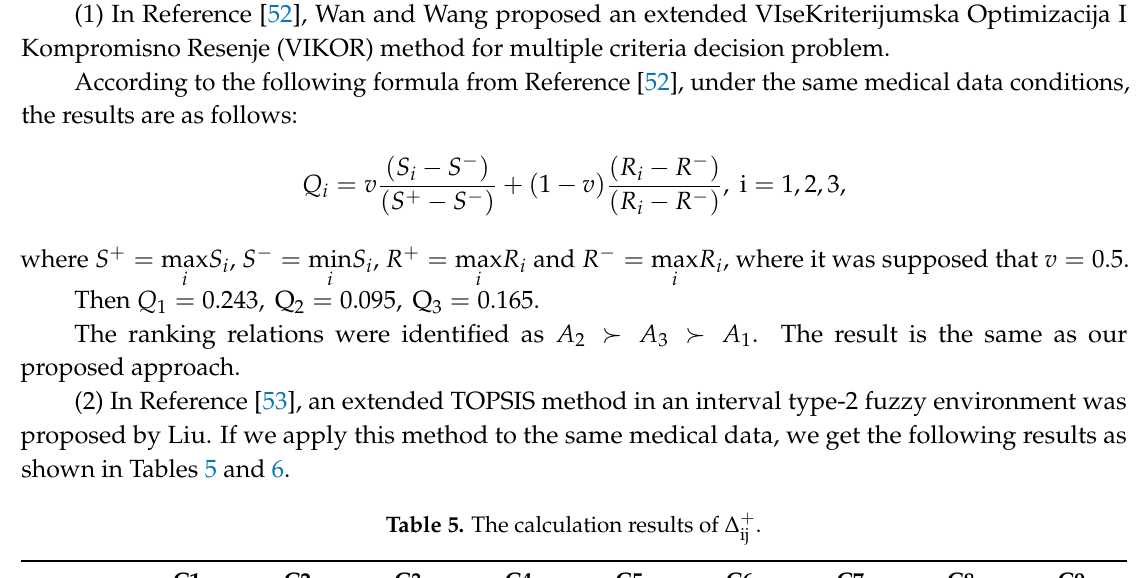
Table 5. The calculation results of ∆ +